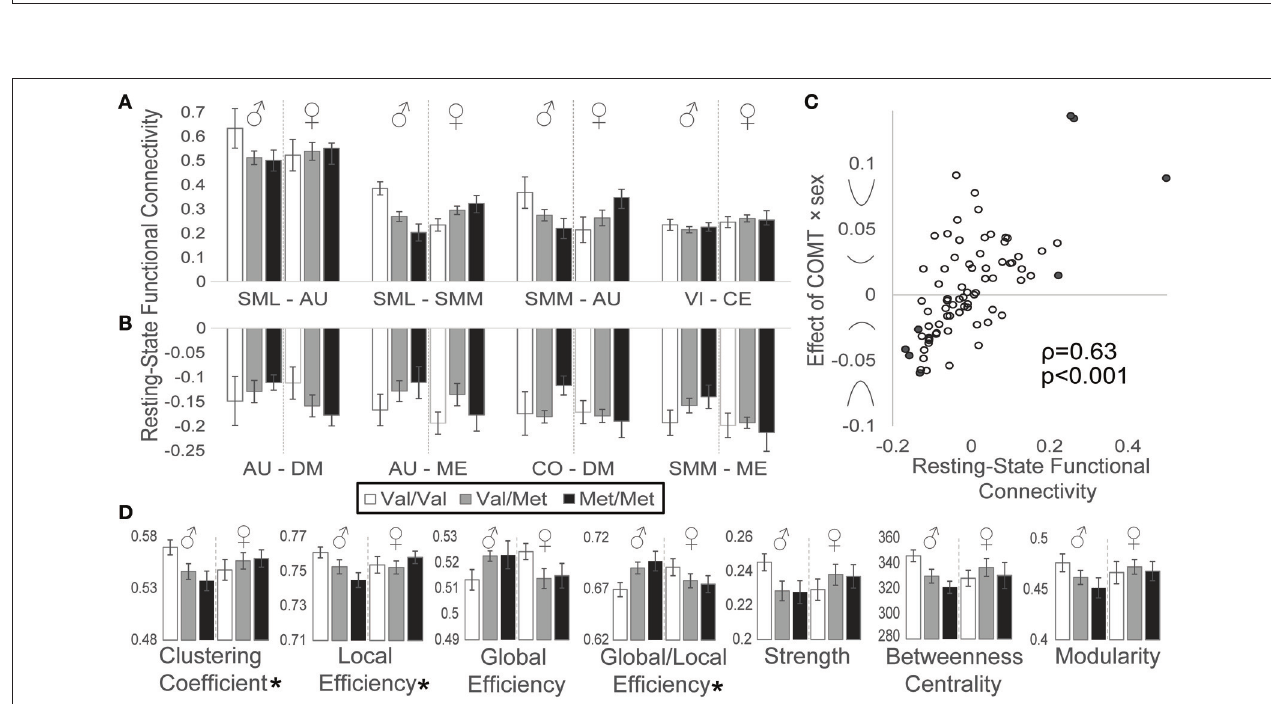
FIGURE 4 | Effects of COMT genotype and sex on functional connectivity during a resting state. Between-network functional connectivity is plotted by COMT genotype and sex for the (A) four most positive and (B) four most negative connections. For display purposes, between-network connectivity was plotted as the averaged Fisher-z-transformed correlation between all ROIs belonging to each pair of networks. Error bars reflect standard errors of the means. (C) Scatter plot of resting-state functional connectivity plotted against COMT genotype × sex interaction effects for each network pair. Symbols on the y-axis correspond with the direction of interaction effects, producing u-shaped (positive values) or inverted u-shaped (negative values) relationships. Filled circles indicate network connections highlighted in panels A and B. (D) Graph theory measures are plotted by COMT genotype and sex. (*) Denotes statistically significant COMT genotype × sex interaction effect measured at the network level. Error bars reflect standard errors of the means. AU, auditory; CE, cerebellar; CO, cingulo-opercular task control; DM, default mode; ME, memory retrieval; SML, lateral sensorimotor; SMM, medial sensorimotor; VI, visual.